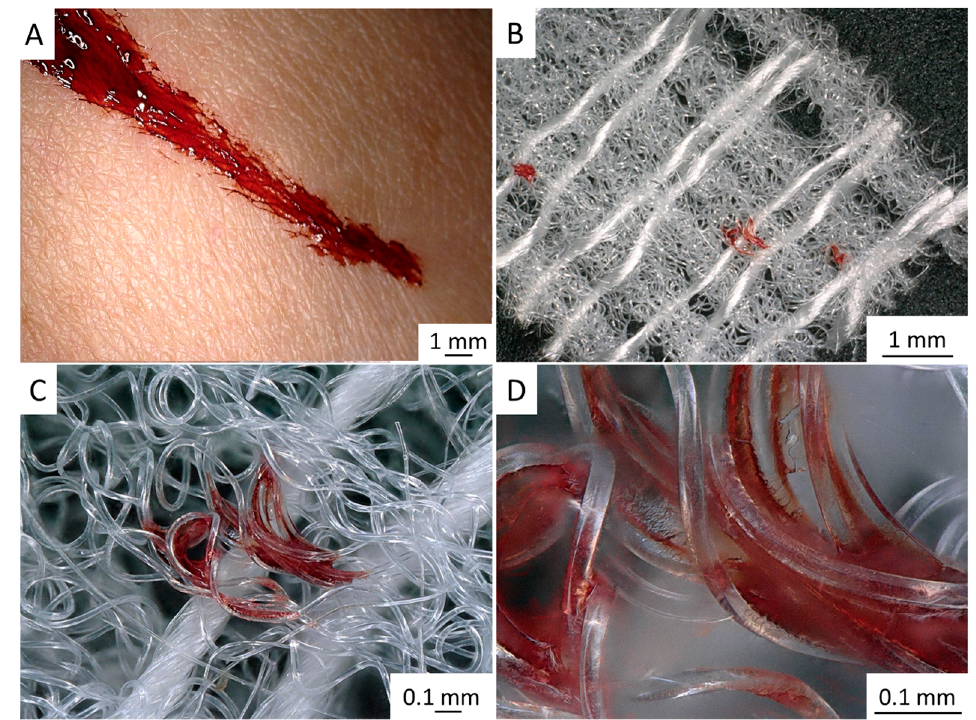
Figure 13. Synthetic bandage Aluderm ® ( A , B ) was used for blood absorption. Absorbed blood ( C ) was located on the surface of corresponding monolithic fibers, as well as between them ( D ).